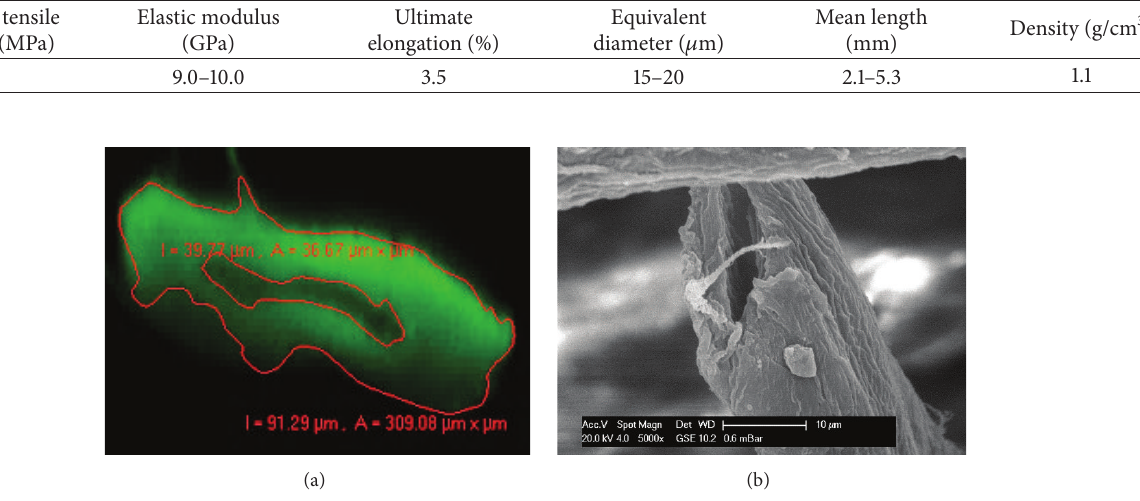
Figure 1: Cross-sectional morphology of cellulose fiber captured by (a) LSCM and (b)